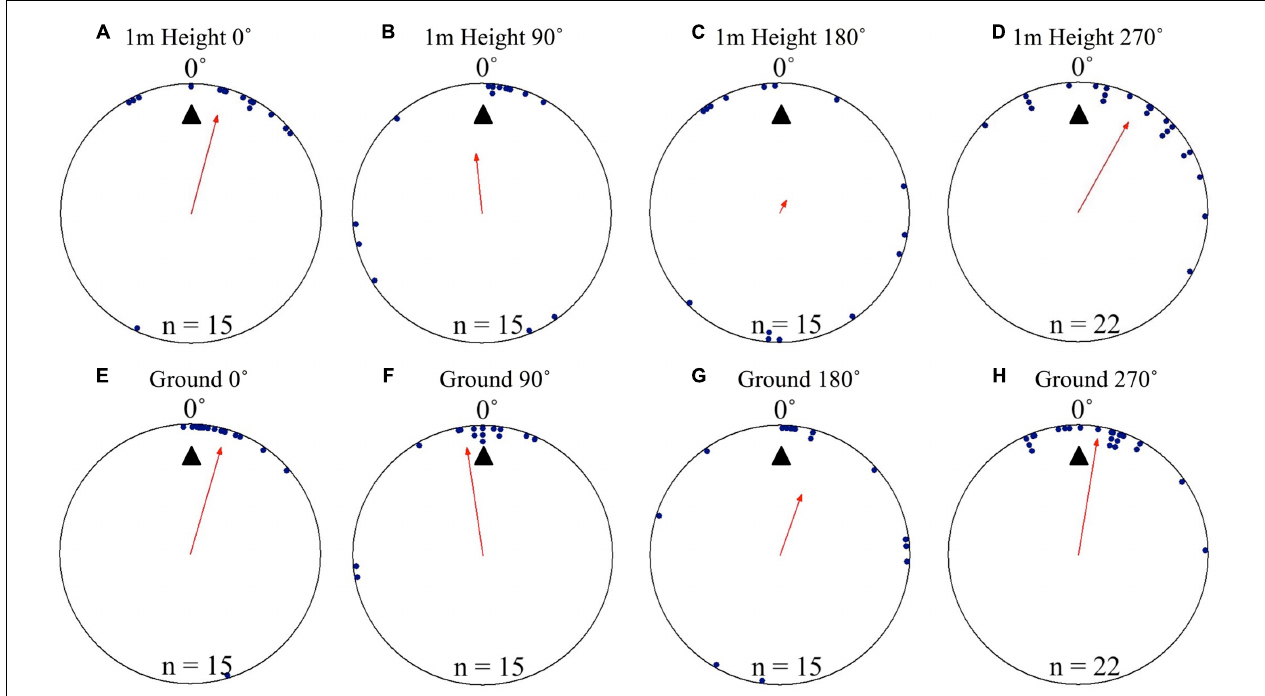
FIGURE 1 | Circular distributions of individual Myrmecia midas foragers’ positions on the tree face during displacement experiments on their foraging tree. Figures show the raw data of forager positions at two heights after displacements to one of four sides of the tree at a 2 m height at Nest 1. The nest direction for each figure is at 0 ◦ , labelled by a black triangle. The arrow denotes the direction and length of the mean vector. Foragers were collected at the base of their foraging tree, held overnight and then released vertically on the tree face at one of four sites (0, 90, 180, and 270 ◦ ). (A) The position of individual foragers released at the 0 ◦ location at 1 m in height. (B) Forager positions of individuals released at the 90 ◦ location at 1 m in height. (C) Forager position of individuals released at the 180 ◦ location at 1 m in height. (D) Forager positions of individuals released at the 270 ◦ location at 1 m in height. (E) The position of individual foragers released at the 0 ◦ location as they reach the ground. (F) Forager positions of individuals released at the 90 ◦ location as they reach the ground. (G) Forager position of individuals released at the 180 ◦ location as they reach the ground. (H) Forager positions of individuals released at the 270 ◦ location as they reach the